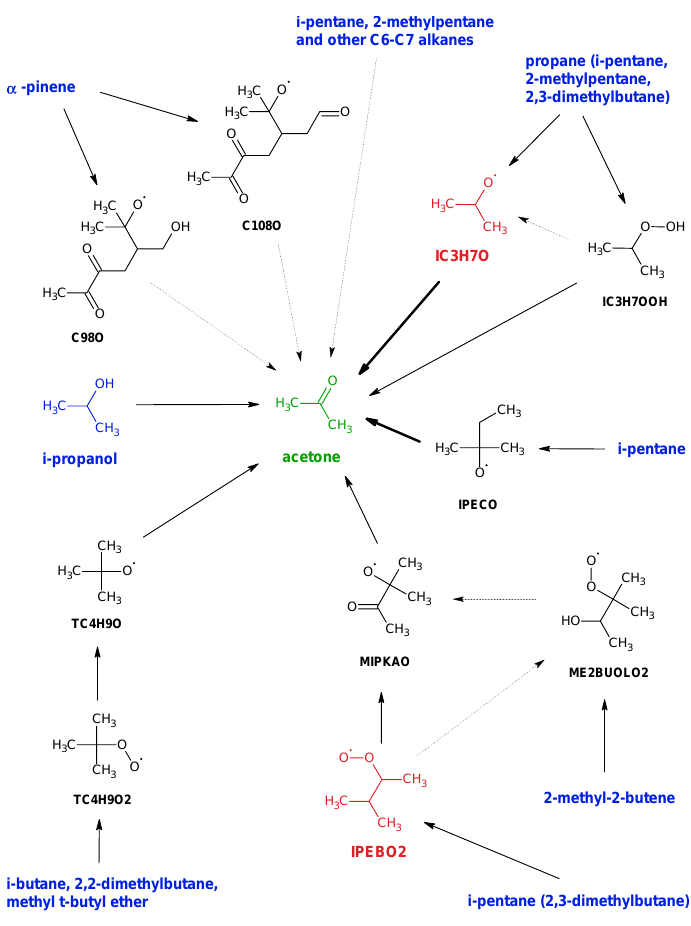
Fig. 7. Reaction scheme for the formation of acetone. Green indicates the target species, blue indicates the VOC precursors and red indicates an intermediate analyzed in detail in Sommariva et al.